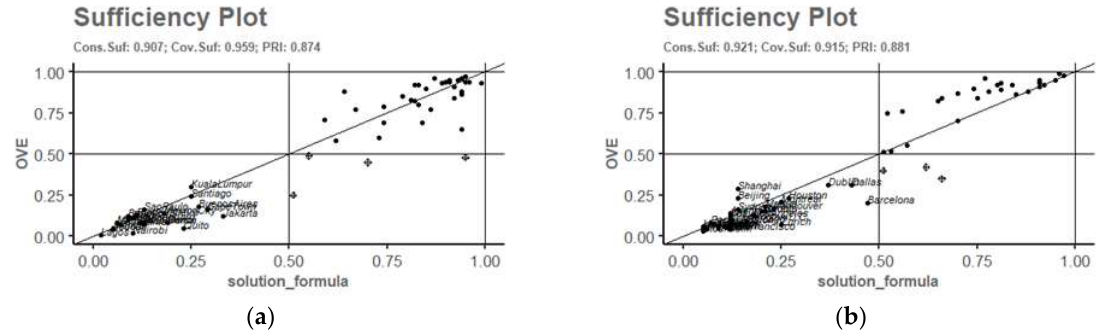
Figure 1. Graphical representation of solutions ( a ) Pimplot OVE; ( b ) Pimplot ~OVE.